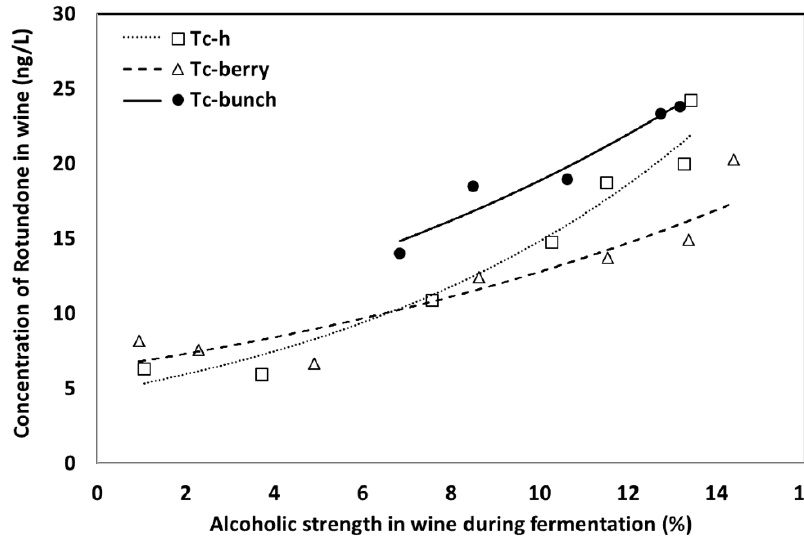
Figure 2. Concentration of rotundone at different alcoholic strength level during winemaking. Wine samples from three commercial fermentation trials were analysed for rotundone concentration on a daily basis from first day of crush until pressing. Tc-h represents crushed berry fermentation ( y = 4.42e 0.1212 x , R 2 = 0.9627, RSME = 1.486); Tc-berry represents whole berry fermentation ( y = 5.966e 0.0773 x , R 2 = 0.882, RSME = 1.837); Tc-bunch represents whole bunch fermentation ( y = 9.007e 0.07415 x , R 2 = 0.9351, RSME = 1.183).